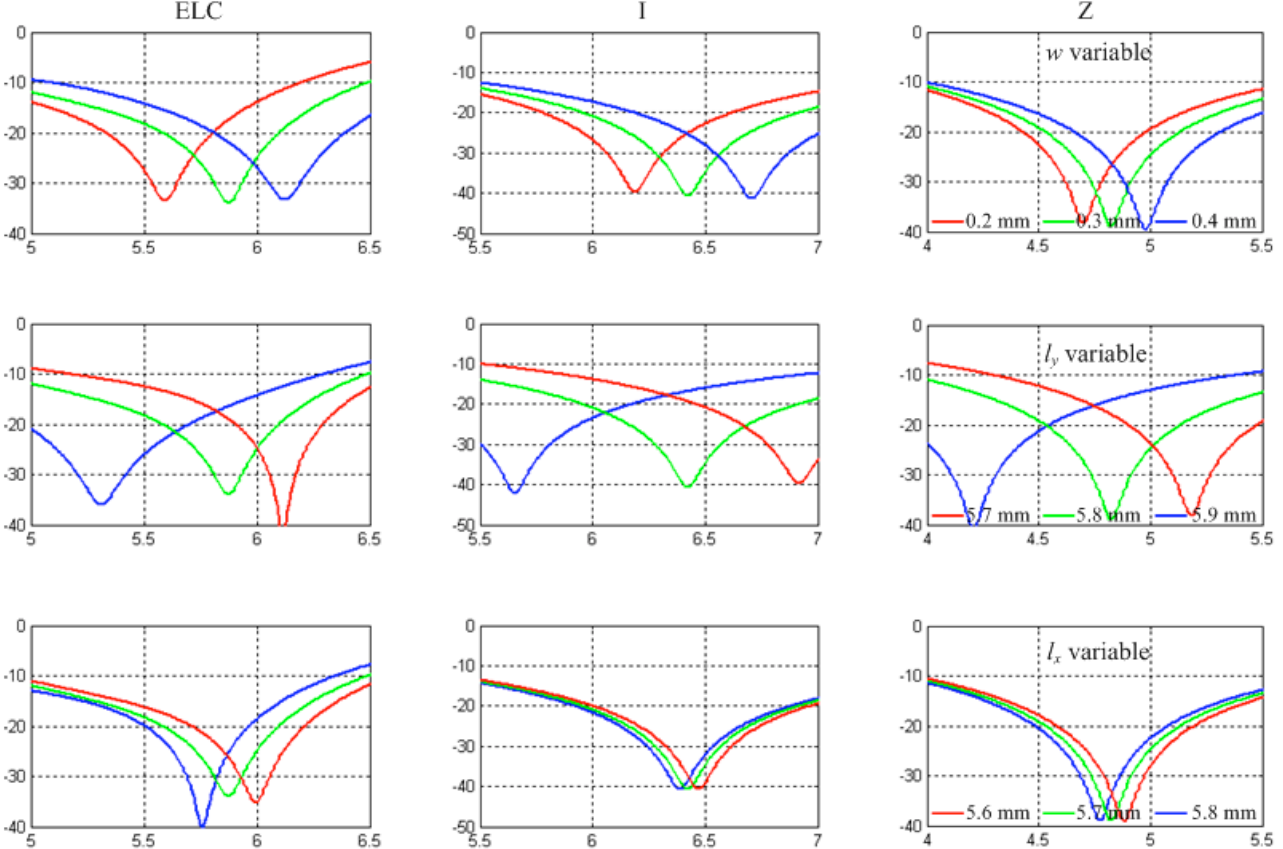
Figure 2: Parametric study of ELC, I-shaped and Z-shaped resonators. Variation of w , l